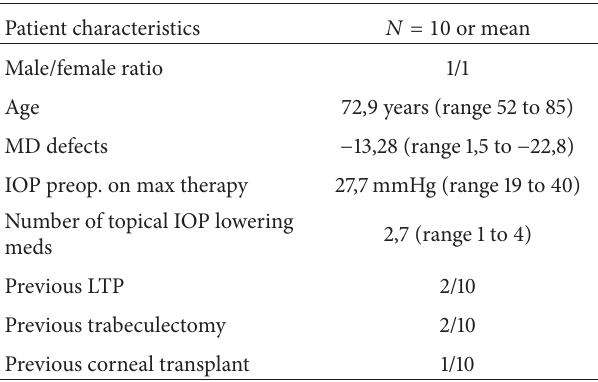
Table 1: Preoperative patient